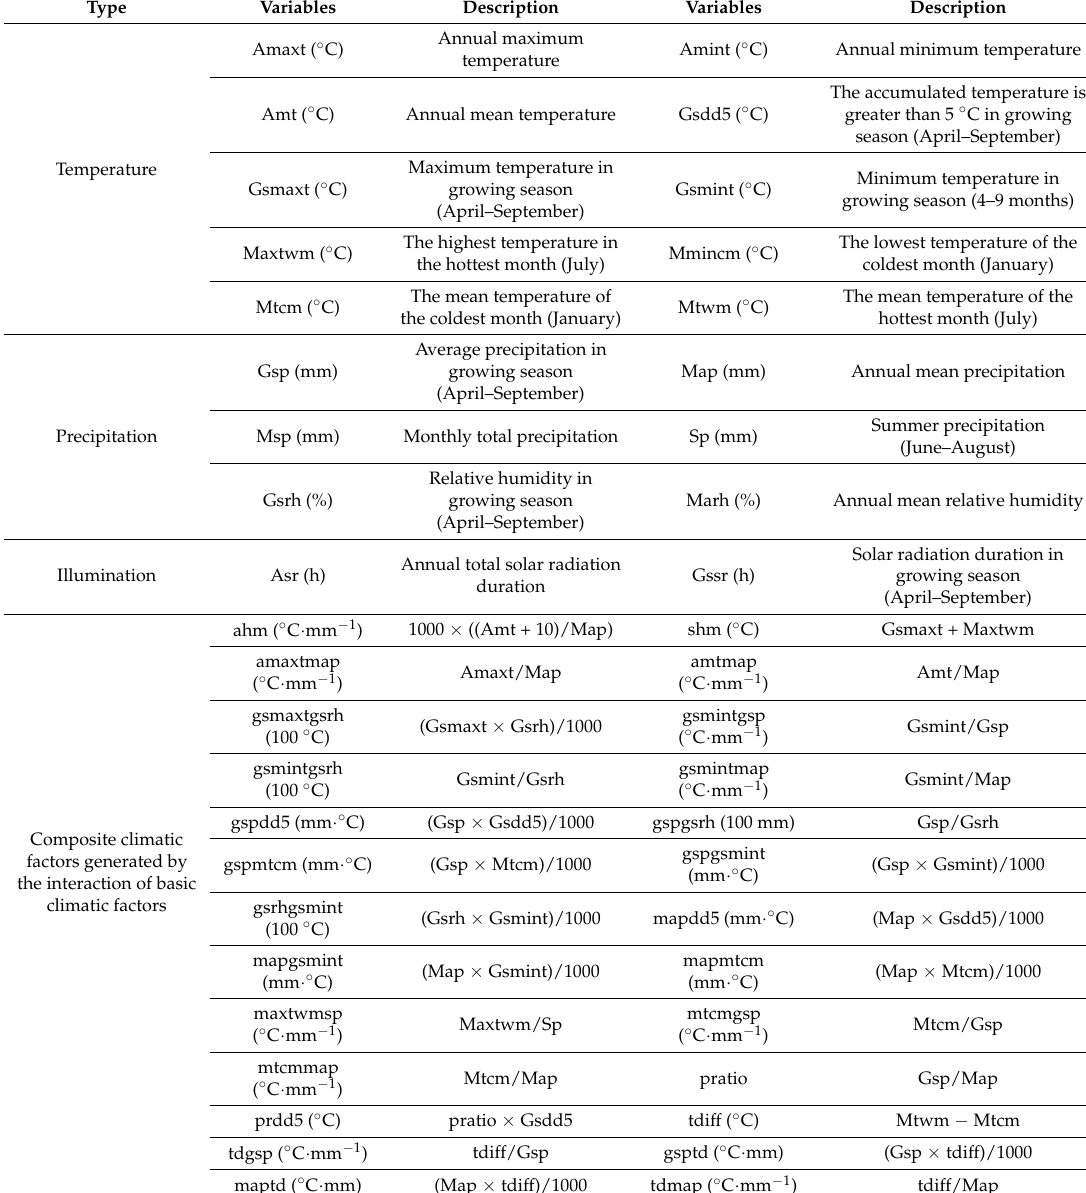
Table 2. Description of 44 candidate climatic